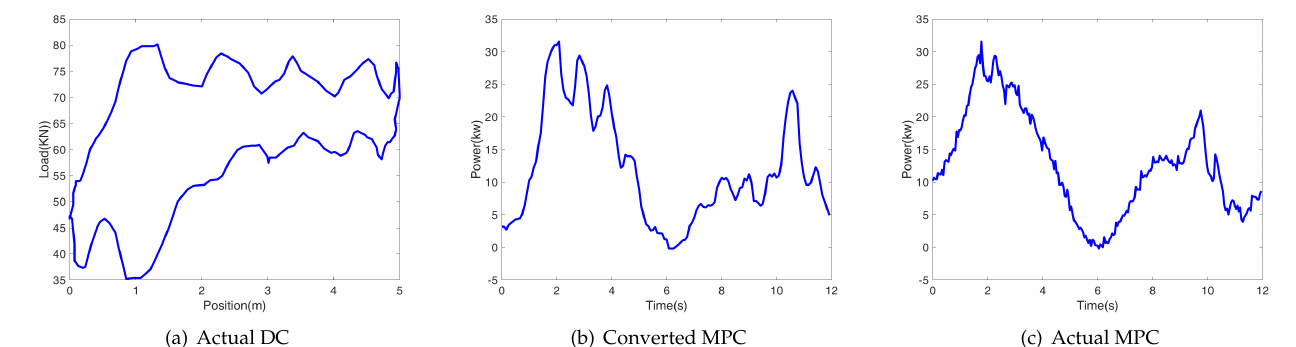
Figure 8. Insufficient liquid supply working